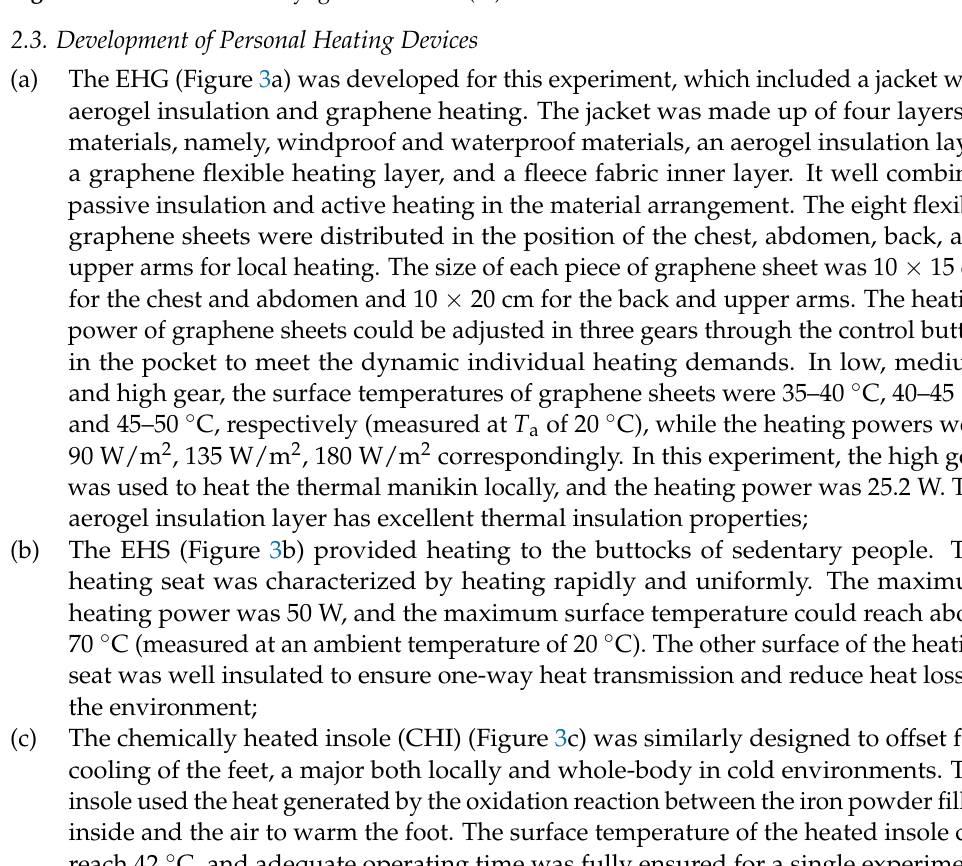
Figure 2. Schematic of the cryogenic chamber (m).